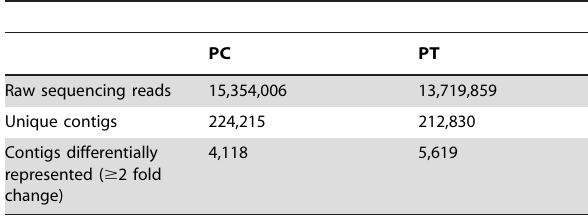
Table 1. Summary statistics of the transcriptome sequencing and assembly for C.gigas from control group (PC) and treated group